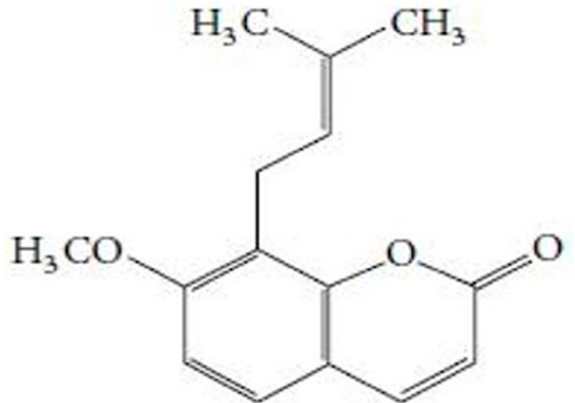
Figure 1. Chemical structure of osthole, [7-methoxy-8-(3-methyl-2-butenyl)-2H-1-benzopyran-2-one], the principle component of Cnidium monnieri (Fructus cnidii) [31].